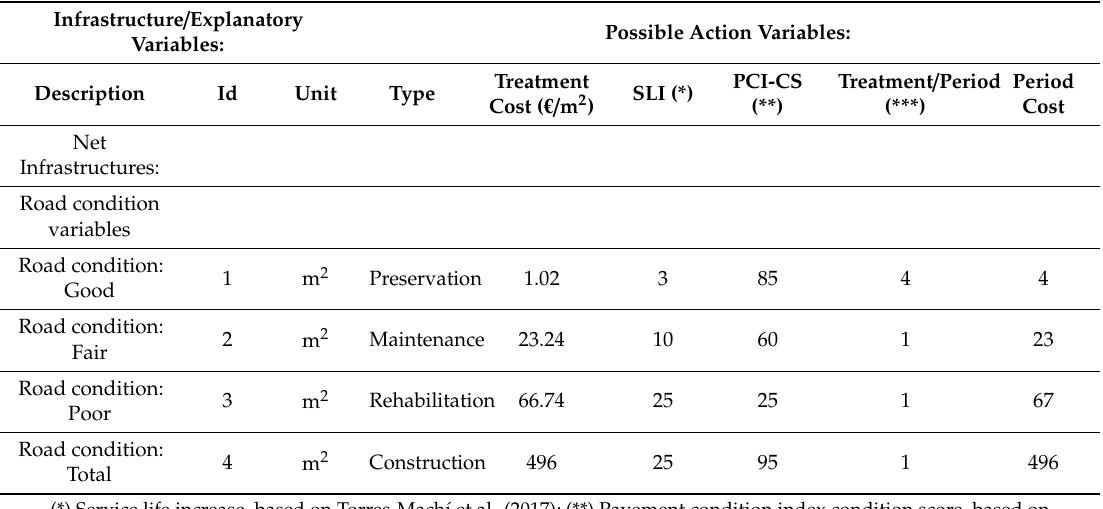
Table 1. Infrastructure condition variables and planning actions.